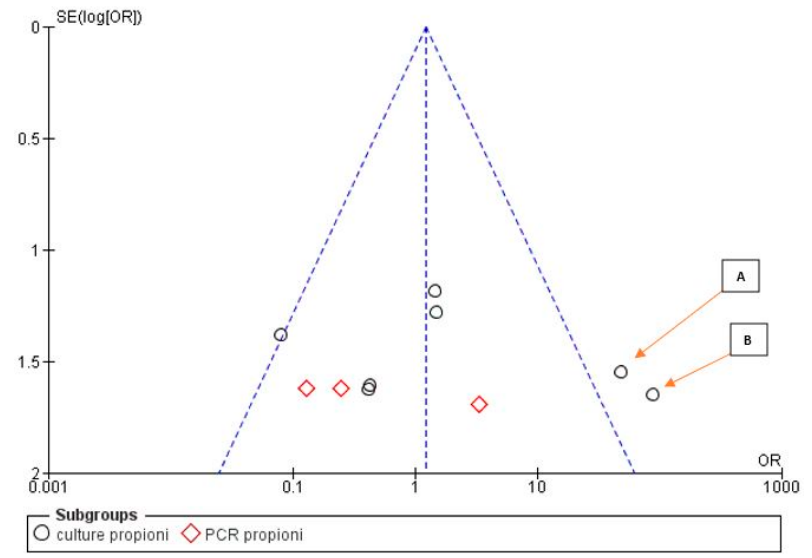
Figure 3. Funnel plot for the sub-group Propionibacterium, I 2 = 56%. The presence of heterogeneity is highlighted graphically. The arrows highlight the sources of heterogeneity A: Fukushima, 1990; B: Sunde, 2002. Sub-group culture I 2 = 64%. Sub-group PCR I 2 = 5%. The heterogeneity between the two sub-groups is I 2 = 13%.